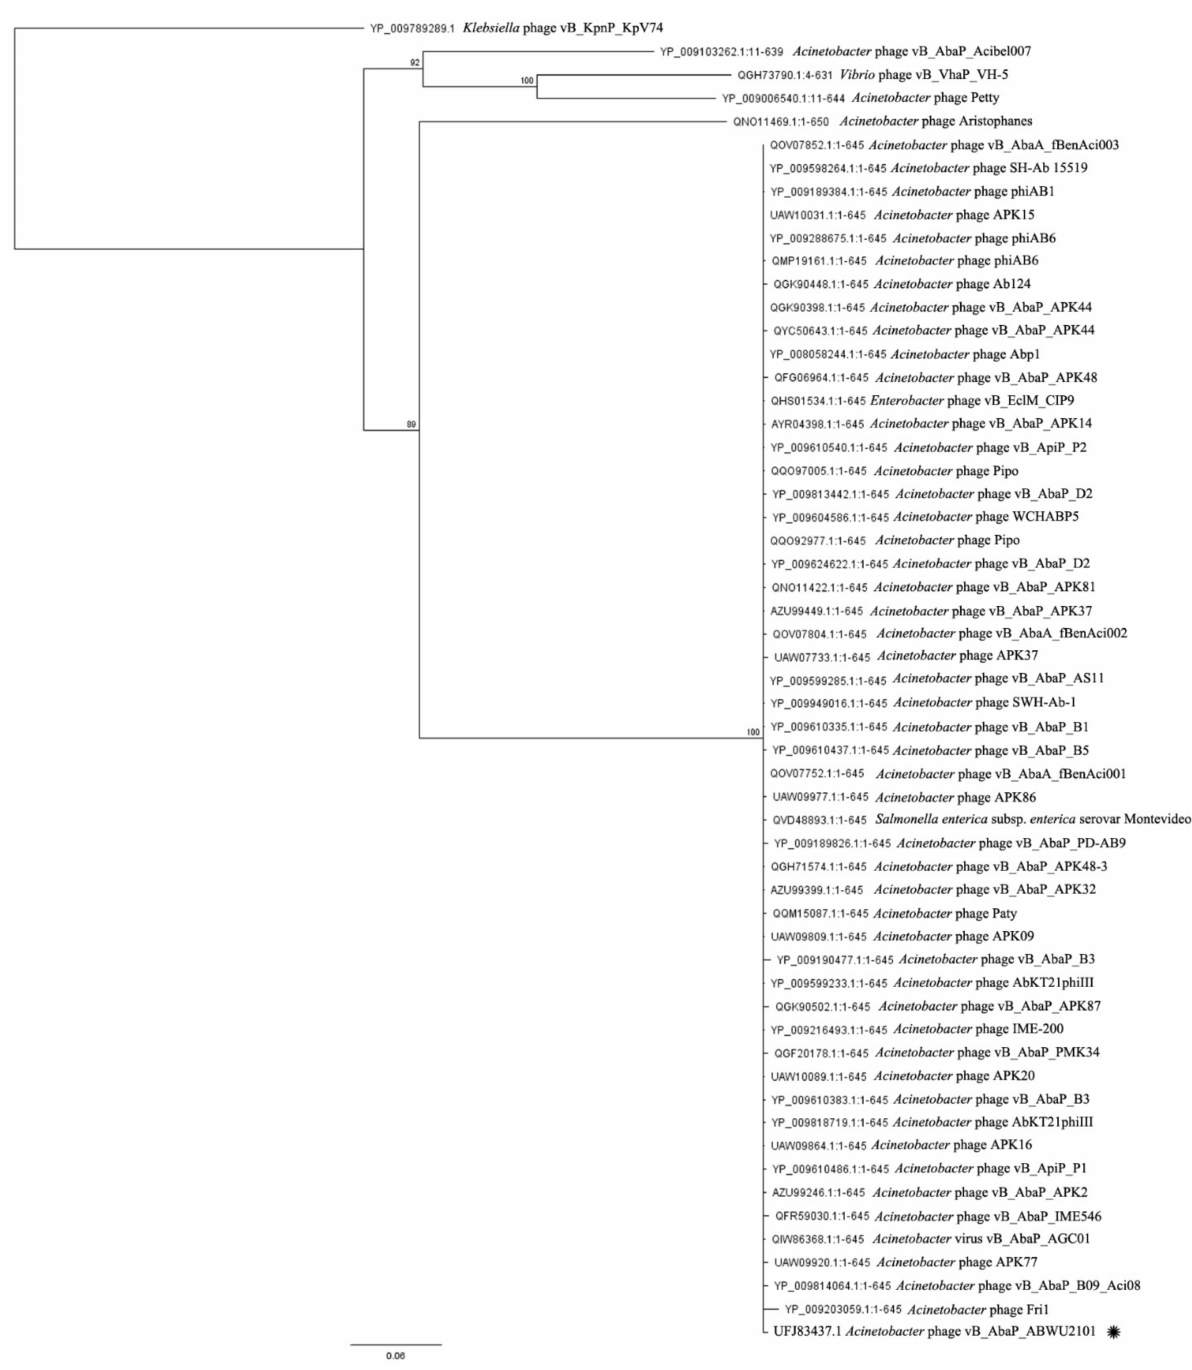
Figure 6. Comparative analysis of phage terminase large subunit proteins. The phylogenetic tree of phage terminase large subunit proteins was generated by the Geneious server using the neighbor- joining phylogenetic tree based on the JTT model with 1000 bootstrap replications. Bootstrap percent- ages (>70) from the neighbor-joining method are represented at the nodes of the branches (above). The scale bar represents 6% amino acid substitution. The query sequence is marked with an